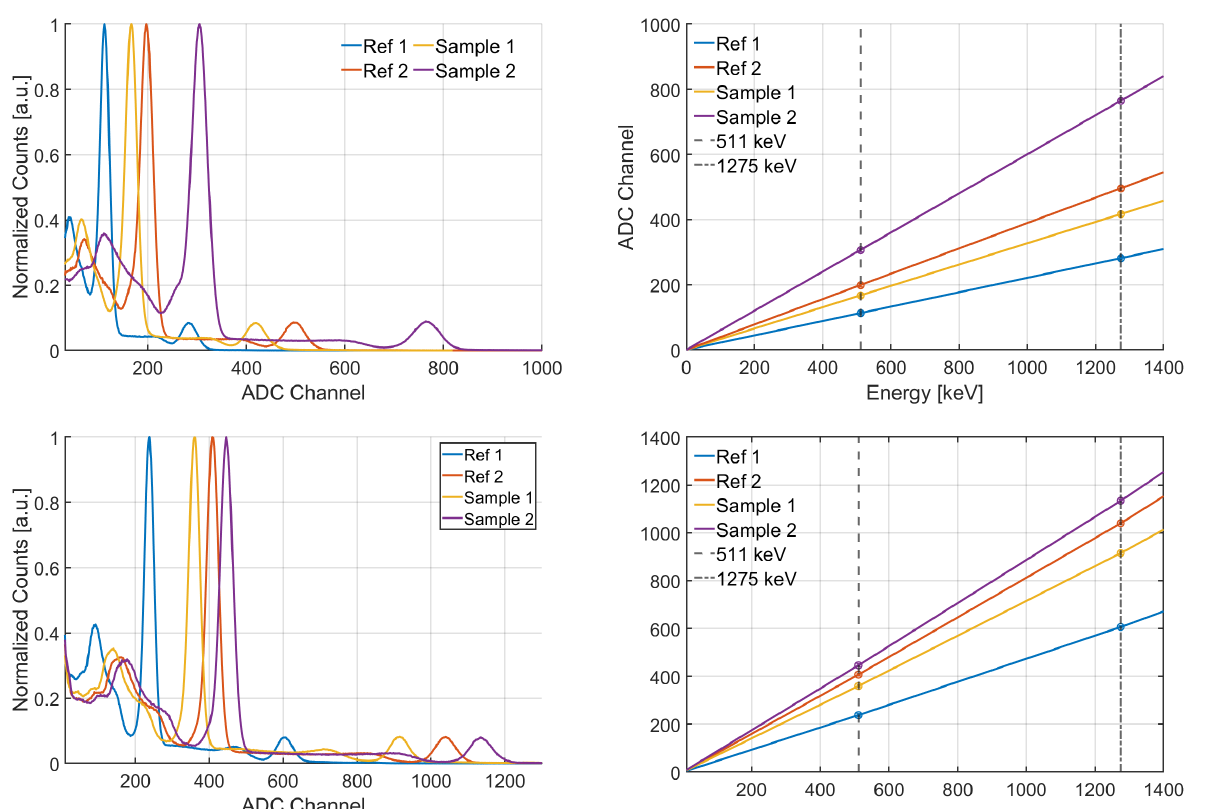
Figure 10. ( Top row, left ): Examples of energy spectra obtained with BGO samples in different configurations. Ref1 : Reference crystal with Teflon wrapping, air-coupled; Sample 1 : Crystal wrapped with Teflon with PhC on the output surface, air-coupled; Ref 2 : Reference crystal with Teflon wrapping and optical grease; Sample 2 : Crystal with Teflon wrapping, PhC on the output surface and optical grease. ( Top row, right ): Corresponding calibration curves derived from the position of the two photopeaks (511 keV and 1275 keV) to eliminate any offset. The slope of the curves provides a visualization of the light gain improvement. Bottom row : Same results for